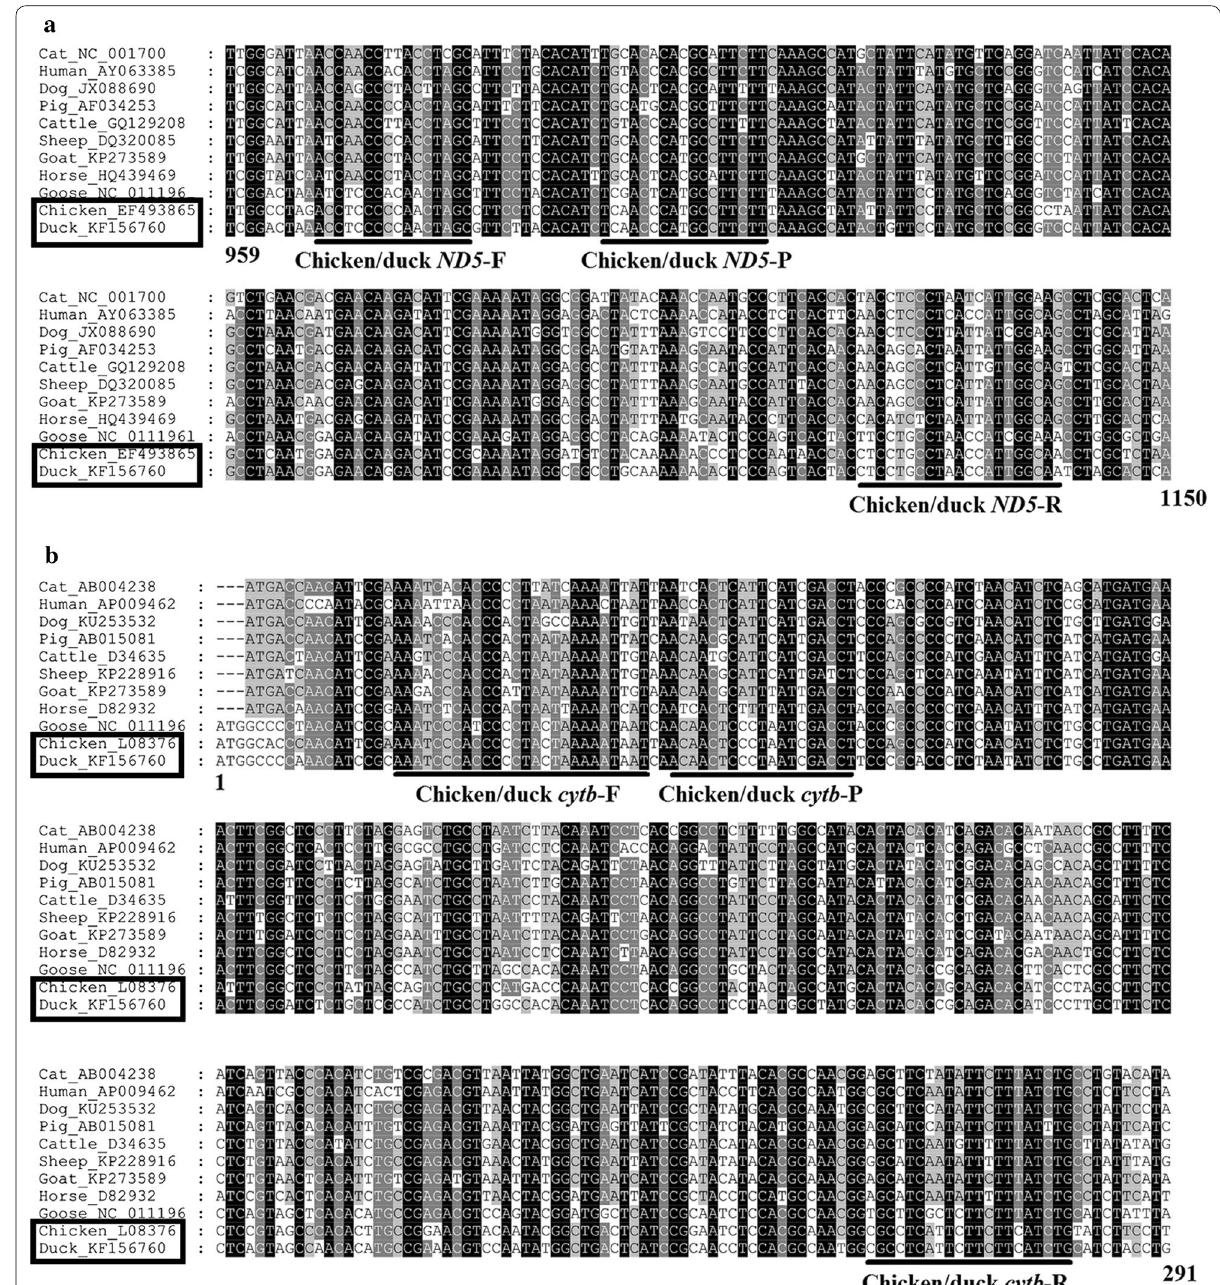
Fig. 1 Alignments of mtDNA ND5 and cytb gene from cat, human, dog, pig, cattle, sheep, goat, horse, goose, chicken, and duck. Binding sites of primers and probes to the mtDNA ND5 and cytb gene sequences are indicated. a mtDNA ND5 assay and b mtDNA cytb